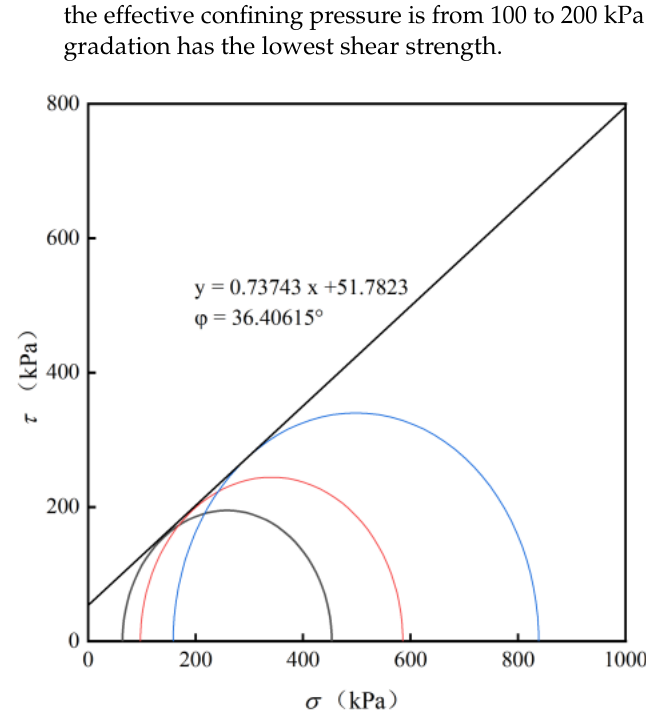
Figure 15. Stress Mohr circle and intensity envelope at C u = 5.5 and C c = 1.5.